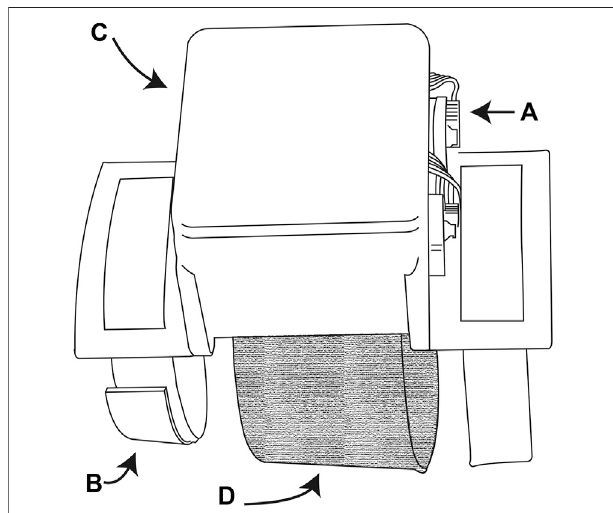
FIGURE 7 | The CUFF. (A) Exposed electronics (motor encoders and connection plugs). (B) Velcro straps used to wear the device. (C) 3D-printed boxenclosingtheelectronicboard. (D) Tissuebandattachedtothemotorsfor squeezing the